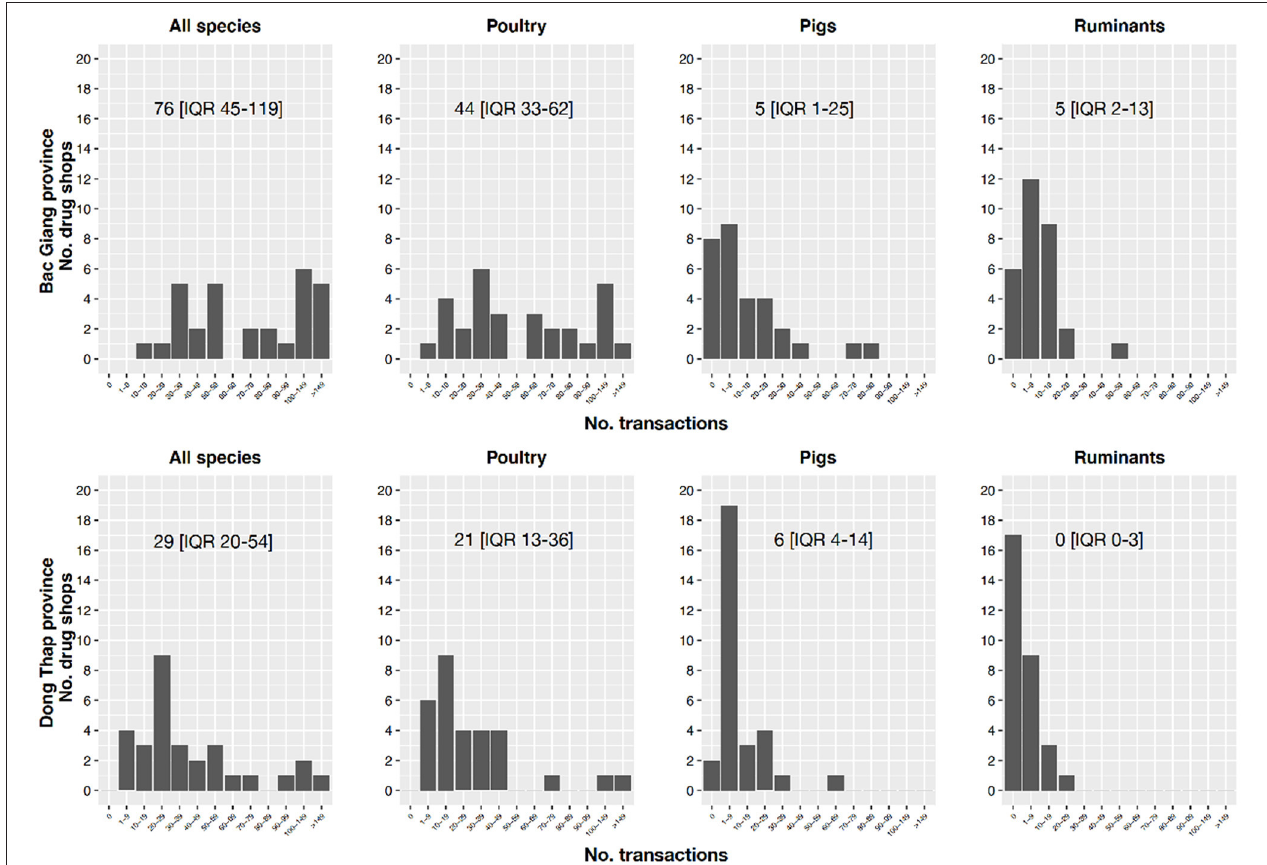
FIGURE 1 | The frequency of transactions in vet drug shop by province and species group during the 3-week survey period.